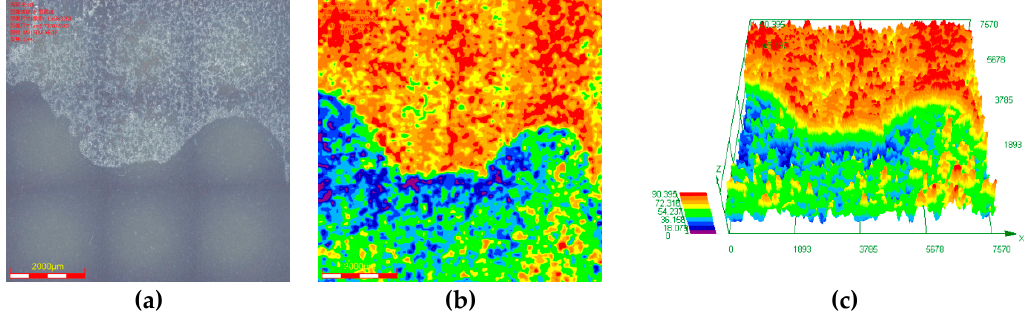
Figure 12. Corrosion depth analysis on the cleaned surface of the sample exposed to 30% crude oil/brine condition at Pco 2 = 1.5 MPa and 65 °C: ( a ) corrosion morphology; ( b ) corrosion depth distribution contour diagram; and ( c ) corrosion depth distribution 3D diagram.